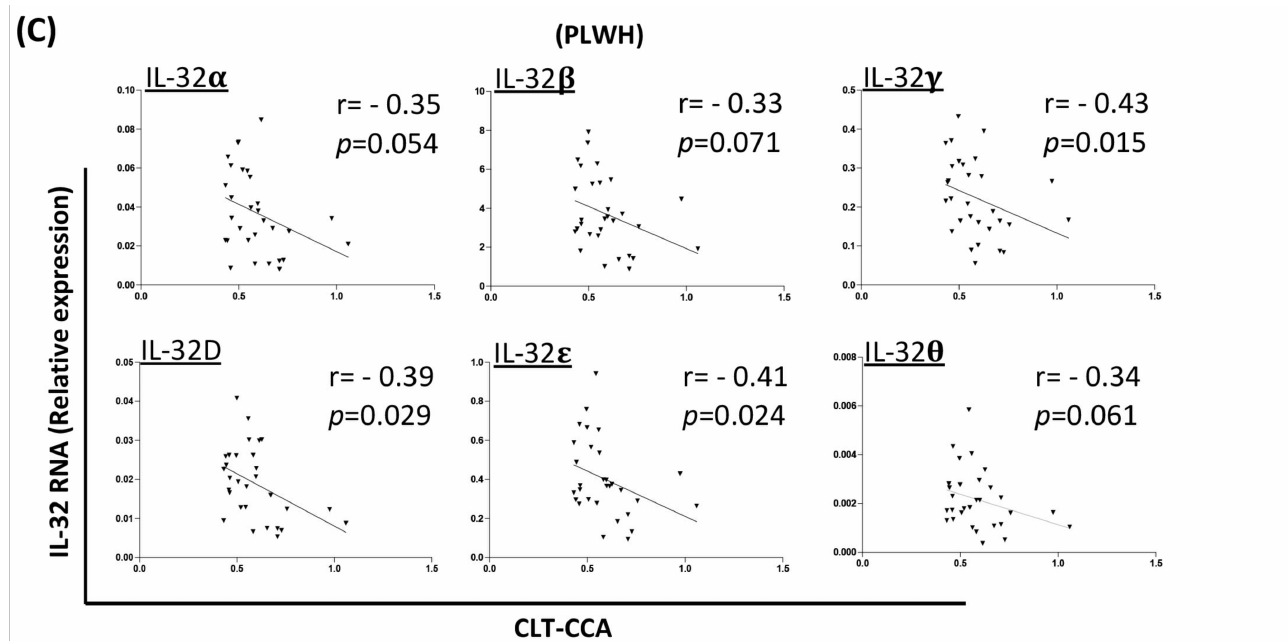
Figure 5. Association between IL-32 expression and carotid artery wall stiffness. ( A ) Increased expression of IL-32 isoforms in PBMCs from PLWH compared to controls (n = 60 and n = 53, respec- tively). IL-32 RNA levels were normalized to the housekeeping gene β -glucuronidase. ( B ) Correlation between IL-32 expression and carotid artery cumulative lateral translation (CLT) within the common carotid artery (CCA) from controls (n = 53). ( C ) Same as in B from PLWH participants (shown is association between IL-32 and CLT data from the upper quartiles, n = 30). Dots on the graphs represent data from individual participants in the CHACS cohort. CLT: Cumulated lateral translation in common carotid artery. CTL: